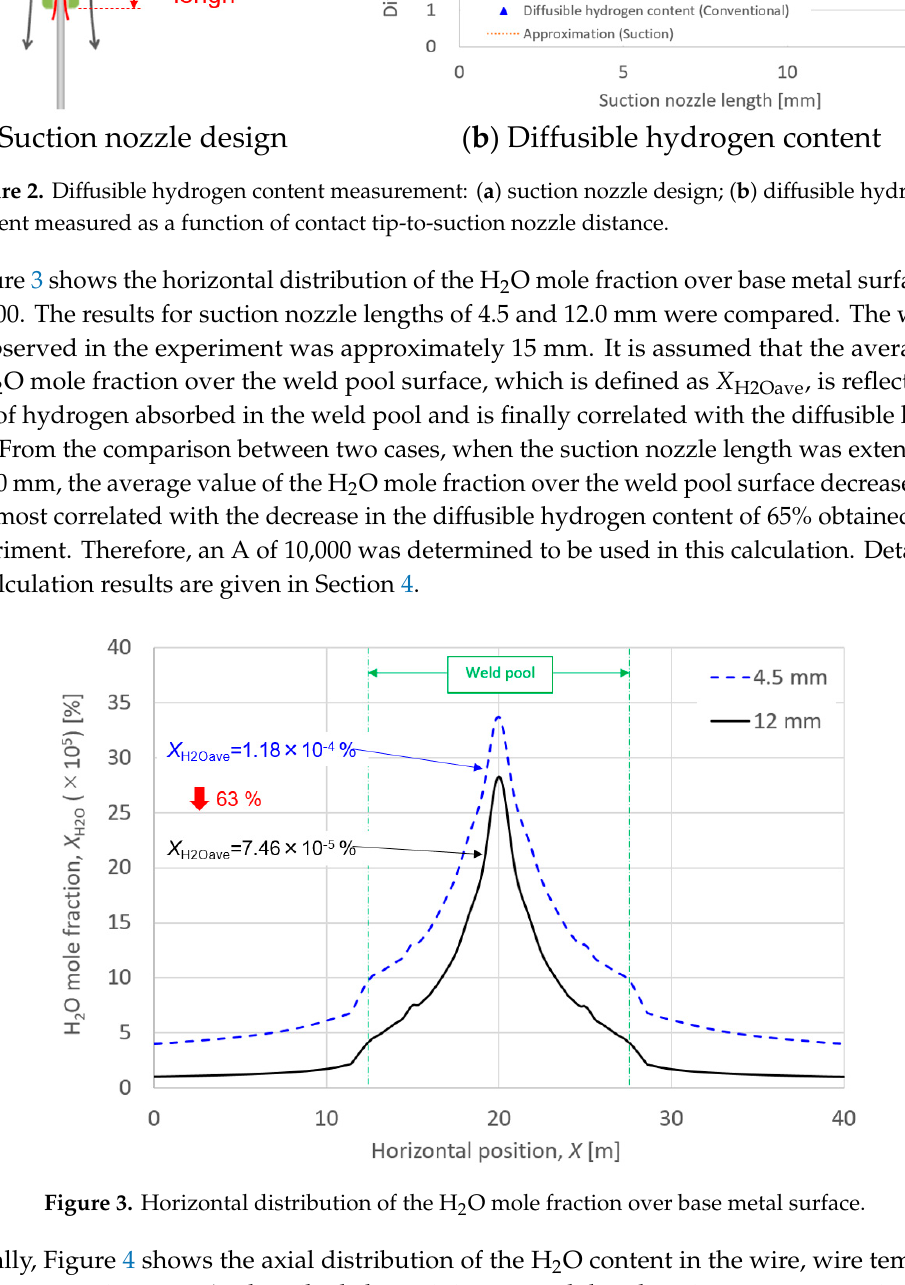
Figure 4. Axial distribution of the H 2 O content in wire, wire temperature and H 2 O evaporation rate. 3. Diffusible Hydrogen Content Measurement The amount of the diffusible hydrogen content in the weld metal was measured by the gas chromatography method according to JIS Z 3118 (2007). This measuring method has good correlation with the mercury method. However, there are different opinions about the constant of proportionality. It has been said that the same level of measurement results can be obtained by both methods [23]. JIS Z 3118 is based on this point. A comprehensive review of several other reports suggests that the value of JIS Z 3118 is approximately 0.7 times larger than the measured value of the mercury method [24–26]. In any case, however, it was considered to be effective as an experimental value used for relative comparison with the simulation. The outline of measurement is as follows. 3.1. Preparation of Measurement Samples A test plate (JIS G 3106 (2015) SM400B (400 MPa class steel): 12 mm × 25 mm × 40 mm) and two end tabs (12 mm × 25 mm × 45 mm) that were subjected to hydrogen removal treatment in advance were welded. End tabs were arranged at both ends of the test plate so that the start and end of welding do not affect the measurement. After welding, the test plate was quenched in iced water and stored in dry ice-saturated alcohol solution after removing the end tabs.